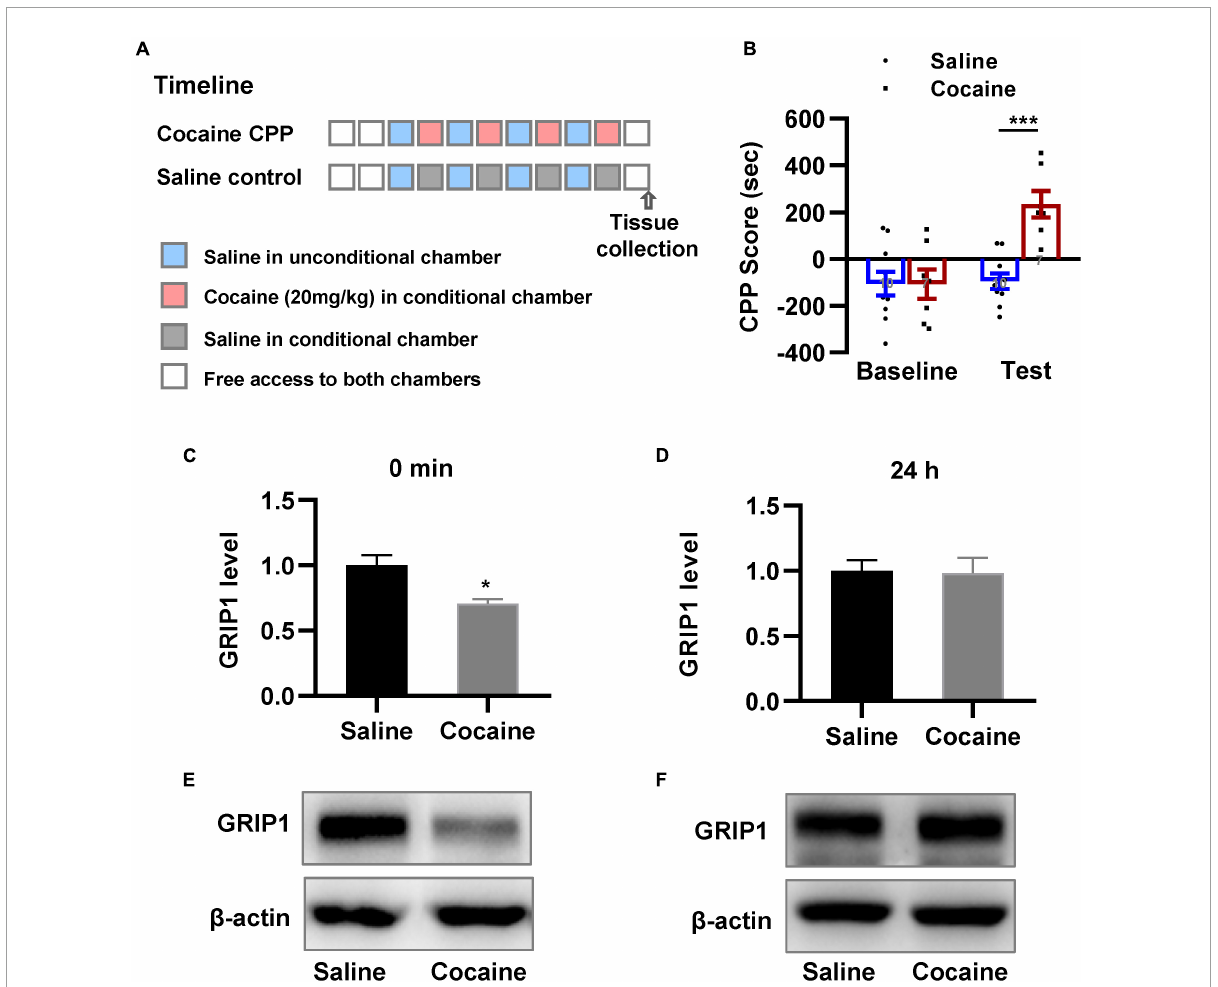
FIGURE1 GRIP1 expression decreases after cocaine acquisition. (A) The timeline of cocaine or saline treatment applied for detecting GRIP1 expression in the NAc. (B) Cocaine-induced increased preference for the cocaine box. Unpaired t test. n = 8 mice per group. (C–F) The expression of GRIP1 in the NAc decreased at 0 min after cocaine acquisition compared to the saline control group (C,E) and returned to baseline at 24 h after cocaine acquisition (D,F) . The saline treatment group was set as 1 for quantification. Student’s t -test. n = 6 mice per group. NAc, nucleus accumbens. * P < 0.05, ** P < 0.01, and *** P <